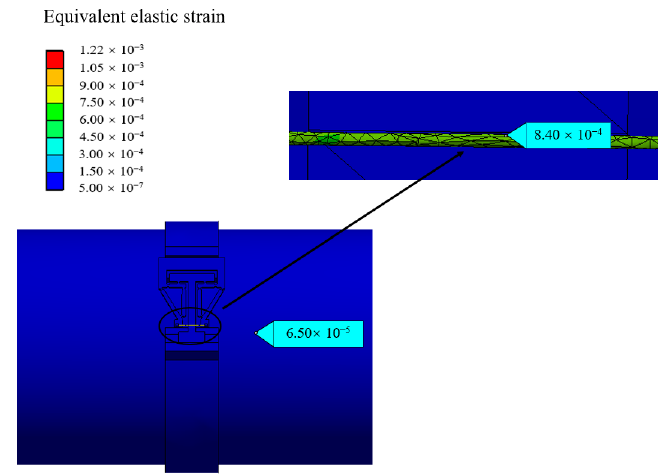
Figure 11. Strain distribution of pipeline wall and sensitization structure.